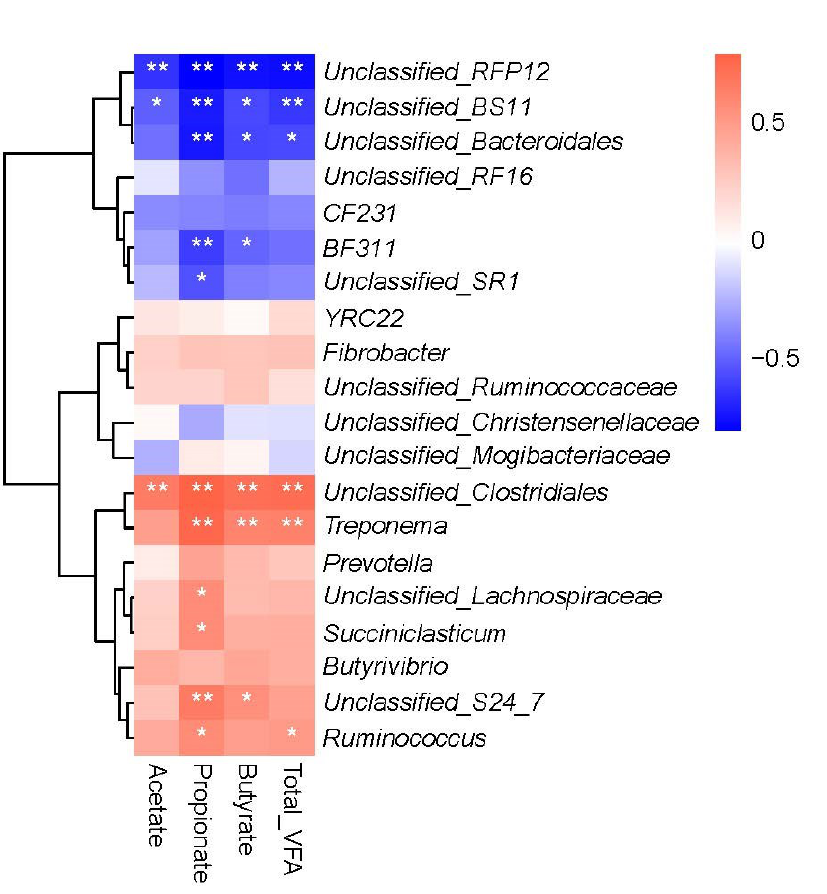
Figure 3. Heatmap showing Spearman correlations between VFAs and top 20 abundant genera. Red color means positive correlation and blue means negative. ** p < 0.01, * p <